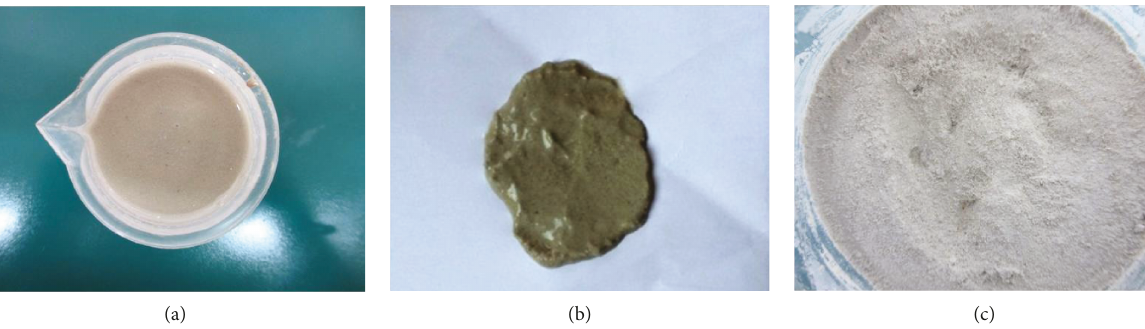
Figure 2: Variation of expandable material with high water content over time: (a) slurry state, (b) cementitious state, and (c) solidi fi ed